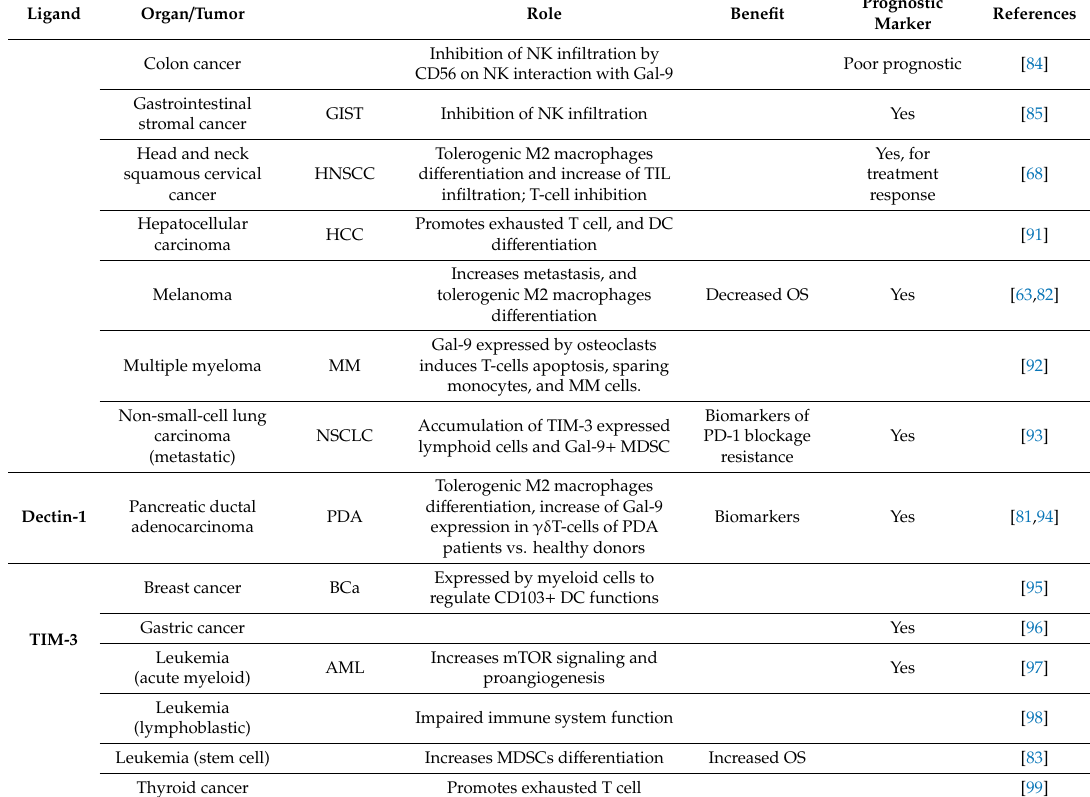
Table 4. Galectin-9 on immune cells in the tumor microenvironment.